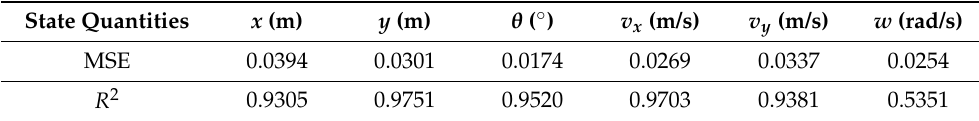
Table 2. Prediction accuracy results for constant driving force modes.